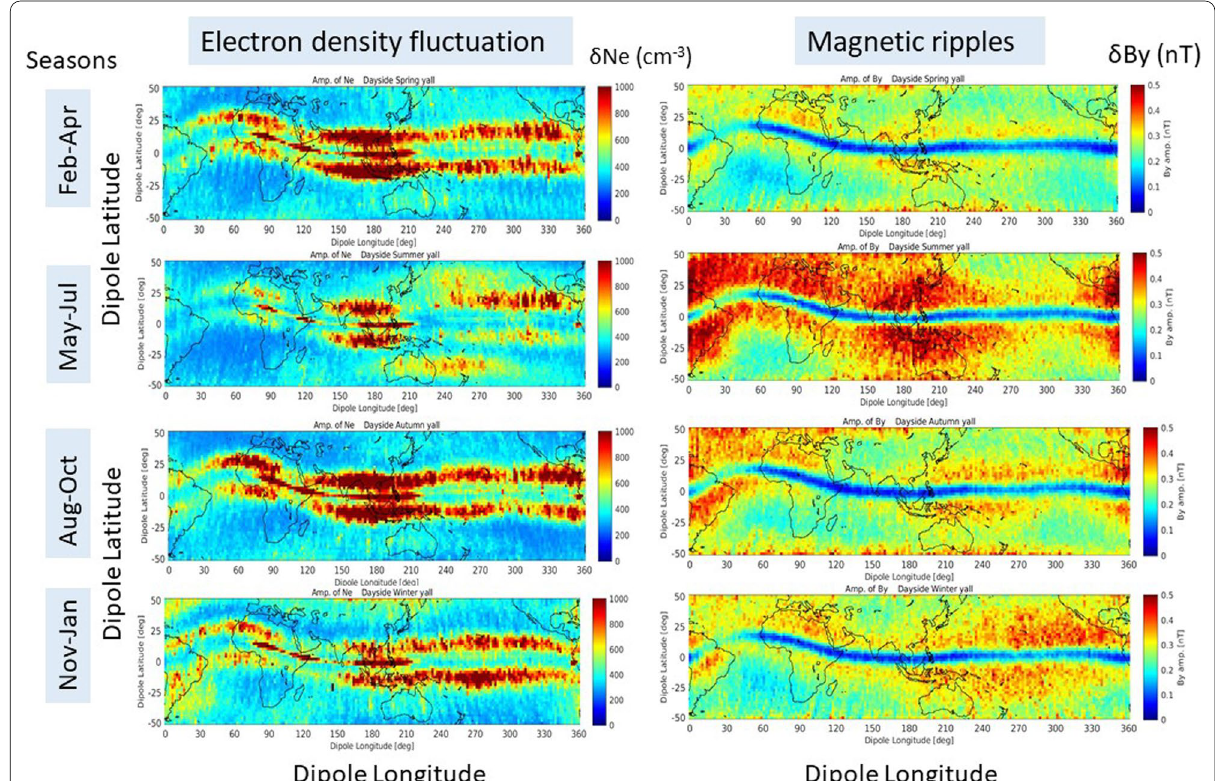
Fig. 3 Amplitude distribution of electron density fluctuations (left) and By-component of magnetic ripples for four